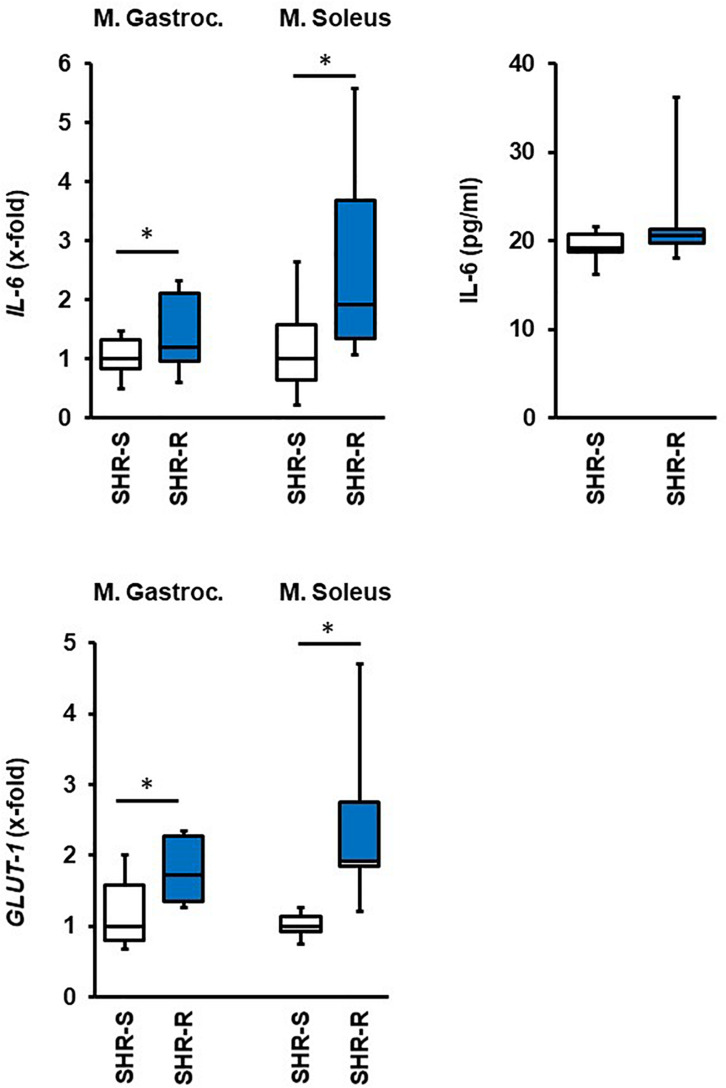
Effect of 2 days free running wheel activity (Run, blue boxes) on mRNA expression of IL-6 and GLUT-1 in muscle tissues in spontaneously hypertensive rats (age: 7 weeks). Sedentary controls (Sed) are set as 1. Data are box plots representing the 25, 50, and 75% quartile and the whiskers representing the total range. Plasma concentration of IL-6 is also given. Data represent the mRNA expression at the age of 7 weeks. n.d., not detectable. ∗p < 0.05 vs. sedentary (sed).